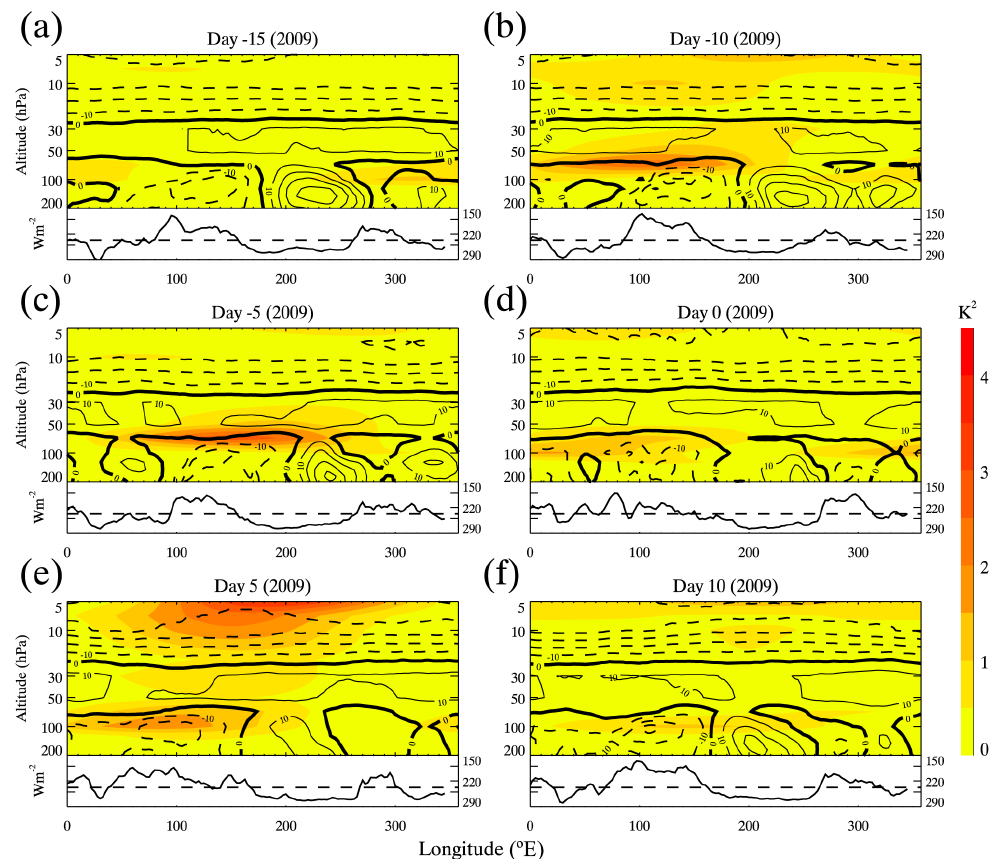
Figure 6. The longitude-altitude cross sections of Kelvin wave strength (color shades), zonal wind (black contours), and the longitudinal series of OLR (black solid lines) at day − 15 (a) , − 10 (b) , − 5 (c) , 0 (d) , 5 (e) , 10 (f) of the 2009 SSW event. All the characters above are averaged between 10 ◦ S-10 ◦ N. The solid contours indicate eastward wind and the dashed ones indicate the westward. Bold contours indicate the zero wind. The data are smoothed by a 5-day running mean. The dashed black lines indicate the zonal mean OLR averaged from day − 15 to day